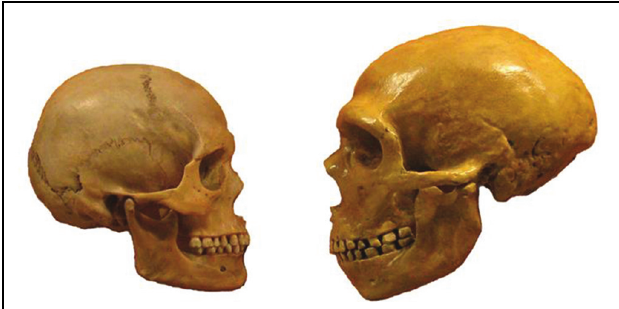
FIGURE 1 | Illustration of the hypothesis: observable skull differences between anatomically modern human (left) and Neanderthal (right).